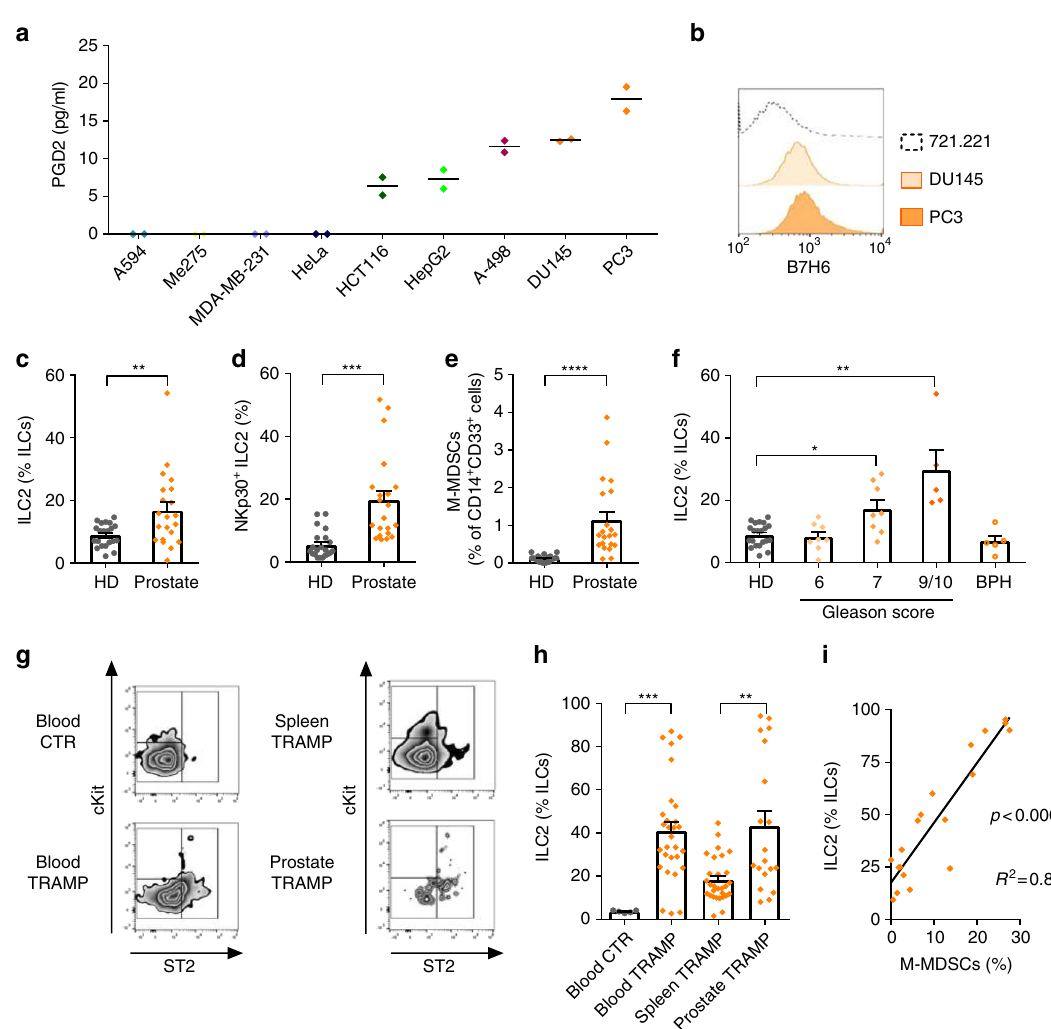
Fig. 6 ILC2 are signi fi cantly increased in prostate cancer. a Quanti fi cation of PGD2 in supernatants of different human cancer cell lines ( n = 2). b Representative example of fl ow cytometry analysis of expression of B7H6 in prostate cancer cell lines DU145 and PC3, or in a control cell line (721.221). c Relative frequencies of the ILC2 subset among total ILCs in healthy donors ( HD ) and prostate cancer patients (Prostate) ( n = 21). d Relative frequencies of NKp30 expressing ILC2 in peripheral blood of HD and Prostate ( n = 21). e Frequency of M-MDSC in peripheral blood of HD and Prostate ( n = 21). f Relative frequencies of the ILC2 subset among total ILCs in healthy donors (HD, n = 21) and prostate cancer patients at stage (Gleason score) 6 ( n = 8), 7 ( n = 8), or 9/10 ( n = 5) or in patients with benign prostate hypertrophy ( BPH , n = 5). g Representative examples of fl ow cytometry analysis of innate lymphoid cell subsets in blood of FVB female mice (blood CTR, n = 5) and in blood ( n = 29), spleen ( n = 29) and prostate ( n = 19) of TRAMP mice. h Relative frequencies of the ILC2 subset among total ILCs in blood of FVB female mice (blood CTR) and in blood, spleen and prostate of TRAMP mice. i Correlation of ILC2 and M-MDSCs in prostate tumours of TRAMP mice ( n = 19) (three independent experiments). Error bars are s.e.m. Statistical analysis was performed using t test ( c – e , h ) and Kruskal-Wallis test ( f